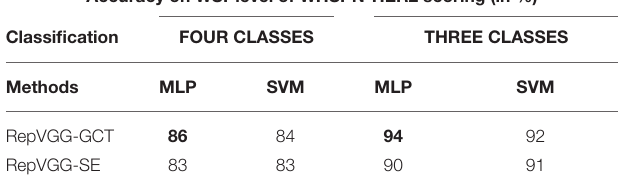
TABLE 6 | Final HER2 evaluation results for the combination of TLCN and